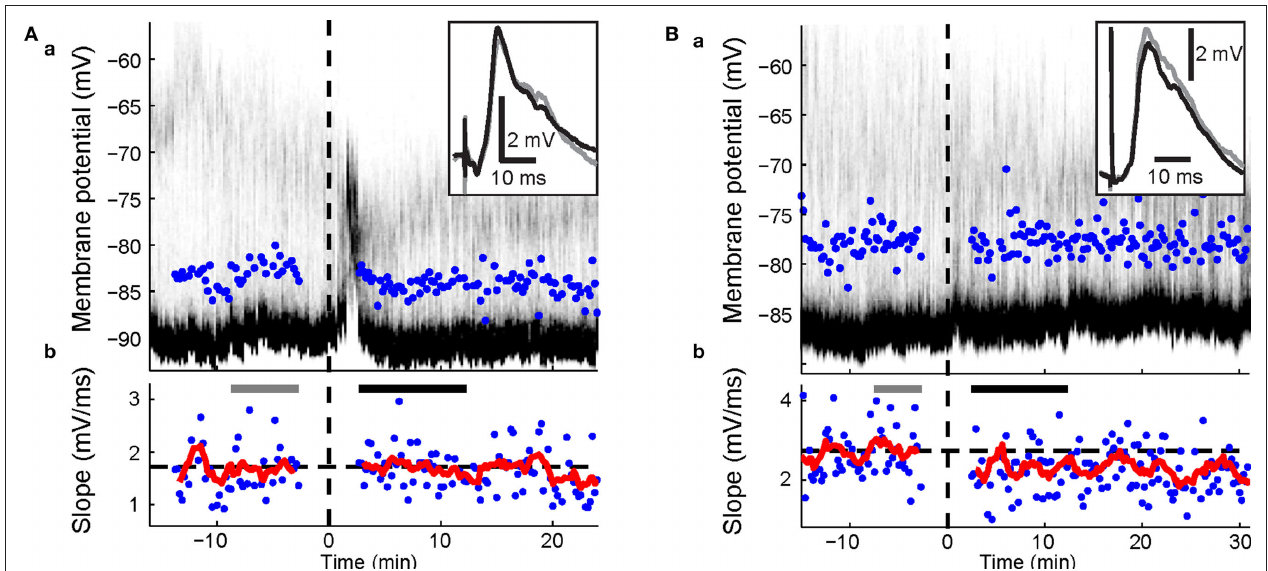
slopes at baseline. Running average of 9 consecutive values is indicated (red trace). PSP traces (top right inset in a) are mean PSPs recorded in the time indicated by the gray and black bars, respectively. (A) Representative example of cortico-striatal HFS with current-evoked spike discharge followed by light. No significant changes were induced. (B) HFS followed by light with current-evoked spike discharge induced depression ( p = 0.002; Wilcoxon rank sum test).